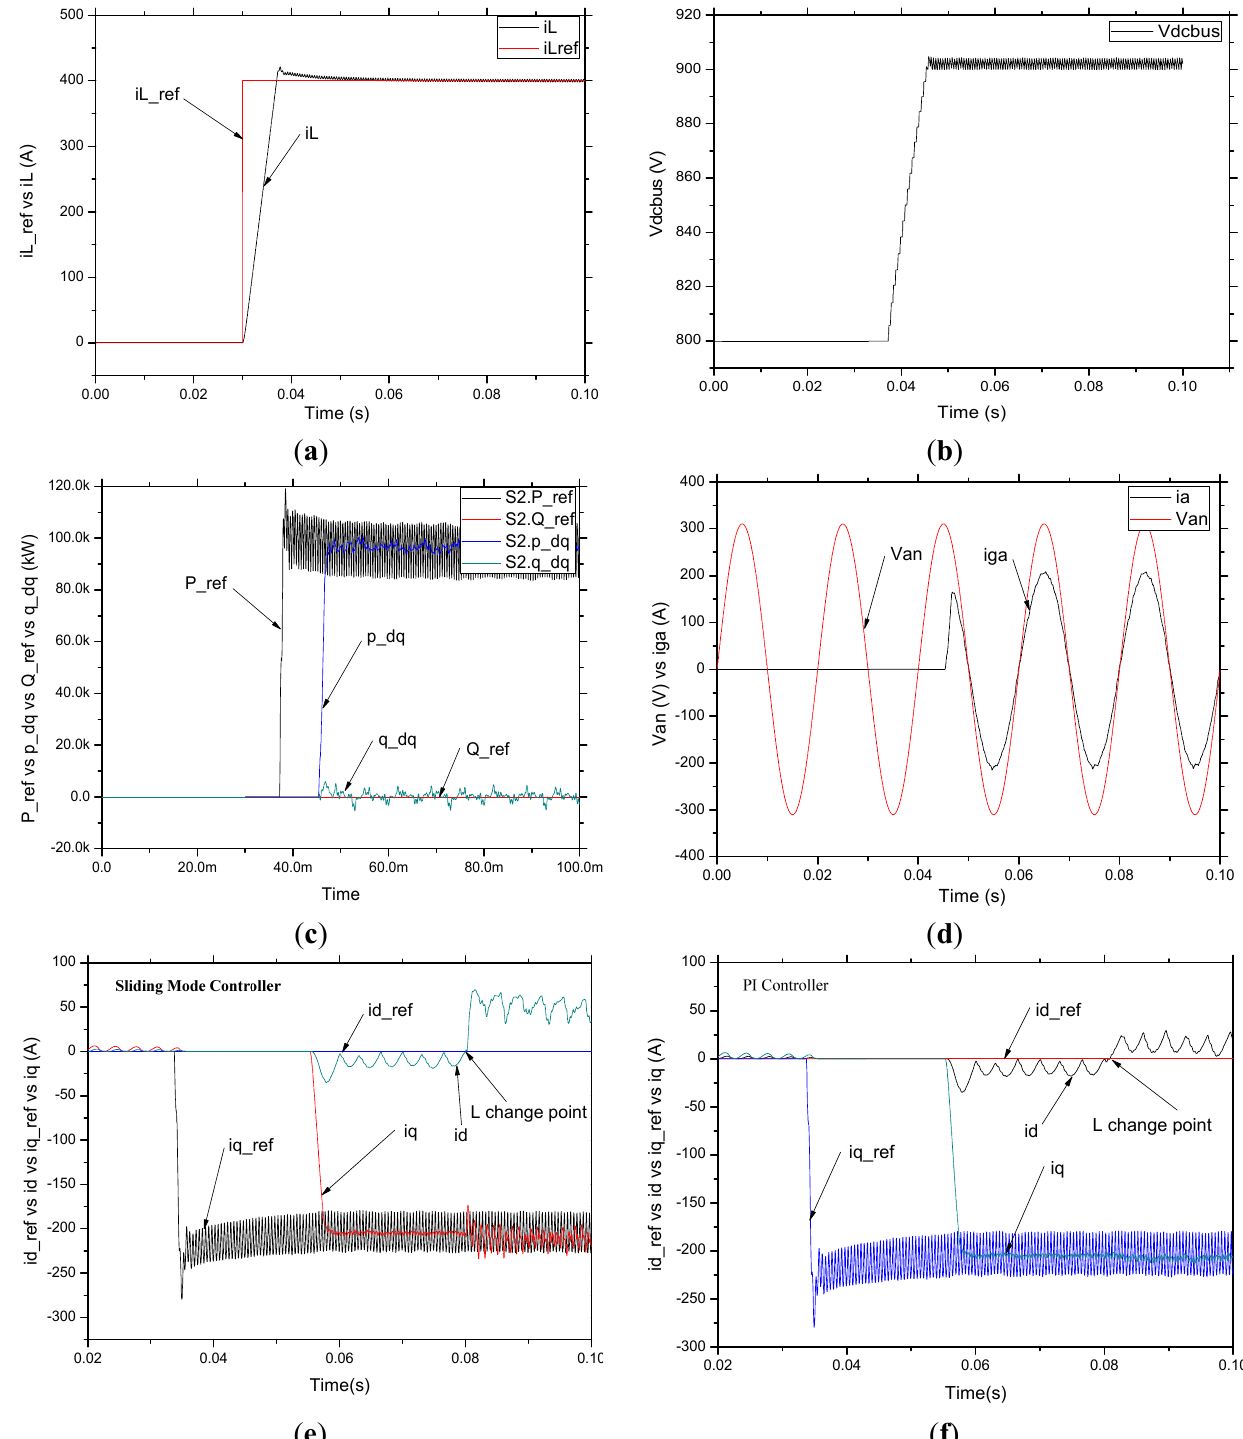
Figure 5. Simulation results of the proposed scheme. ( a ) Time response of reference discharging current and feedback current; ( b ) Time response of dc-link voltage; ( c ) Time response of reference active and reactive power; ( d ) Time response of the grid-connected ) and grid voltage ( v ); ( e ) Time response of the active and reactive phase current ( i ga ga , i ) using a sliding mode controller; ( f ) Time response of the active and reactive currents ( i d q , i ) using PI currents ( i d q